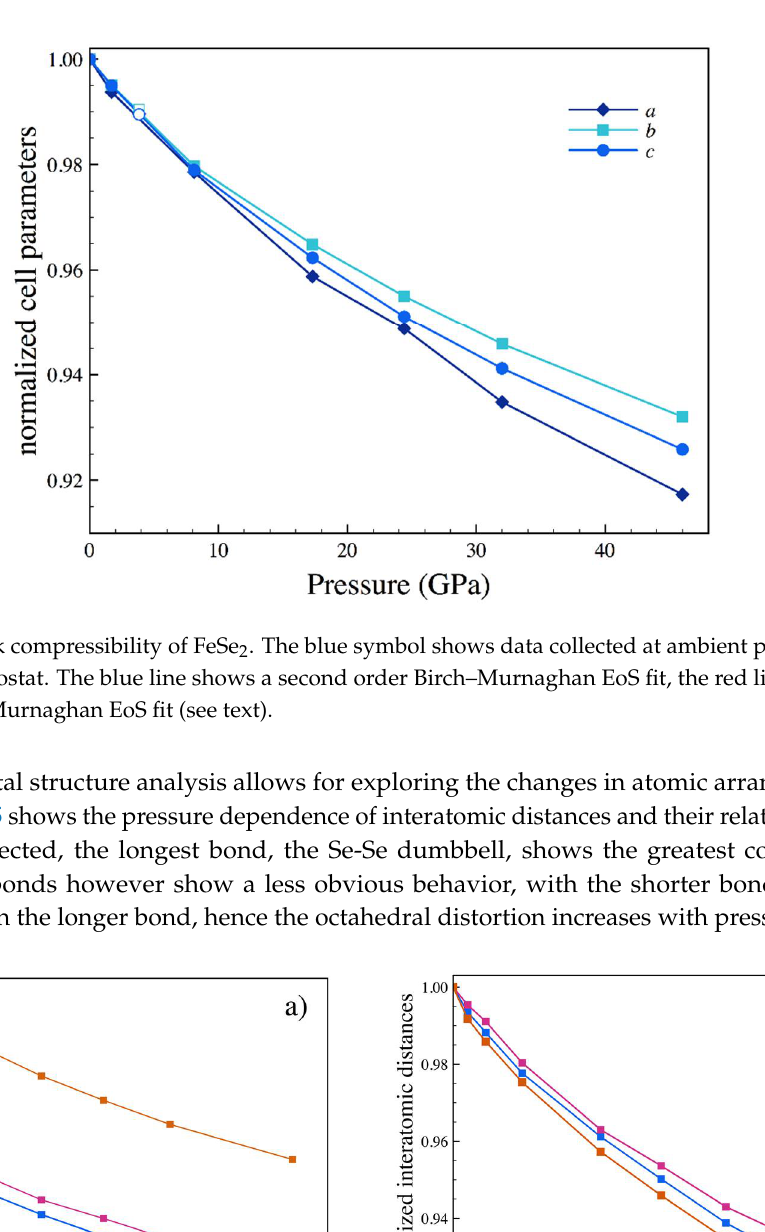
Figure 5. Absolute ( a ) and relative ( b ) interatomic distances as a function of pressure. Uncertainties are smaller than the symbols’ sizes.